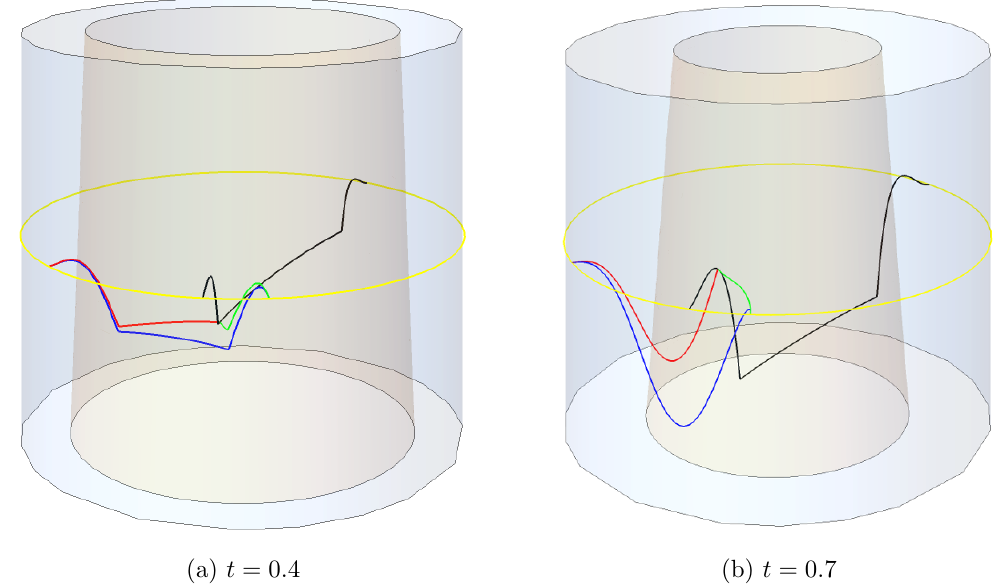
(a) t = 0 : 4 (b) t = 0 : 7 Figure 10. In the (cid:12)gures, the blue cylinder represents the asymptotic boundary, the orange cone denotes the infalling shell and the yellow circle denotes the constant time slice of the boundary. The HRT surfaces (cid:13) ( A ) and (cid:13) ( R ) are in color blue and black. The constrained surface (cid:13) R ( A ) is the union of the red curve and the green